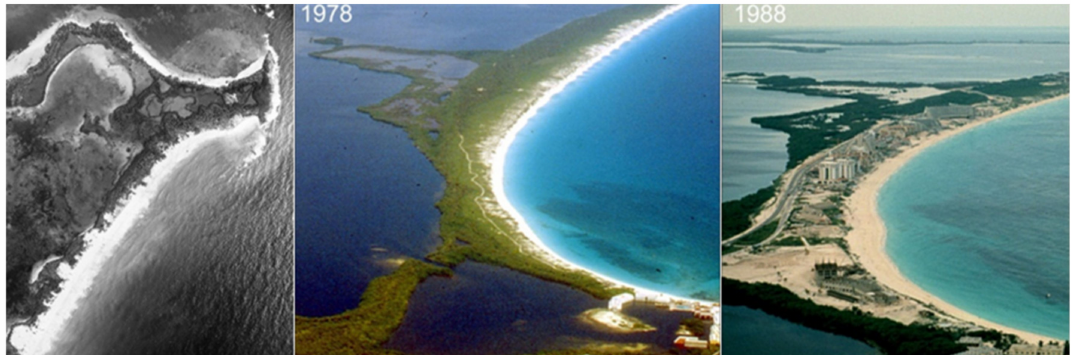
Figure 2. Historical aerial images of Cancun. Punta Canc ú n in 1947 (left panel) and Punta Nizuc in 1978 and 1988 (center and right panels, respectively).